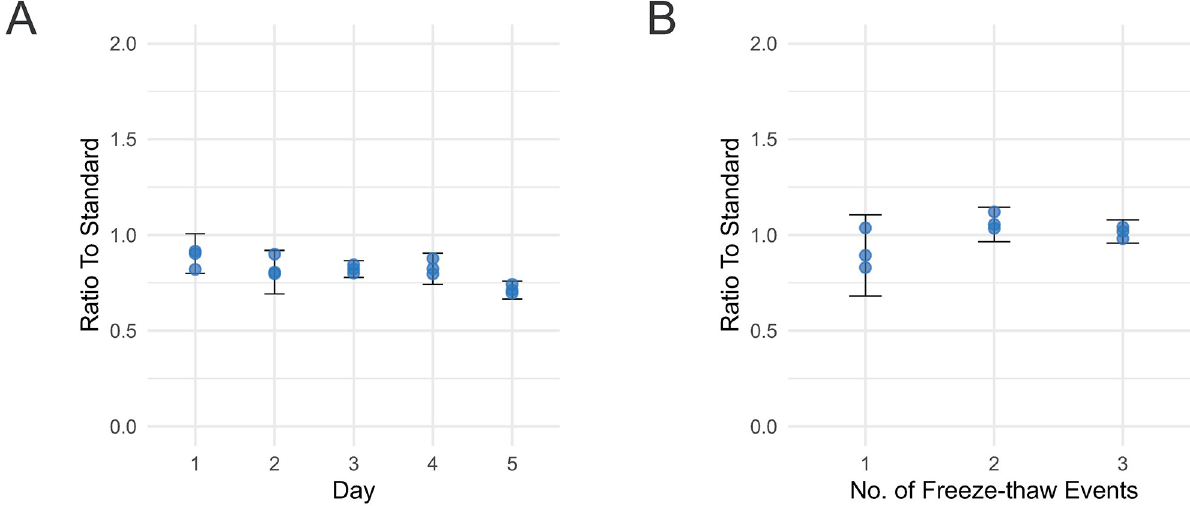
Fig 2. A) Repeatability data indicating the intraday variation during each day of the five-day period and the overall inter-day variation of the proteotypic peptide. B) Stability freeze-thaw data of three cycles for the proteotypic peptides. In both figures 2 times standard deviation interval is visualized with error